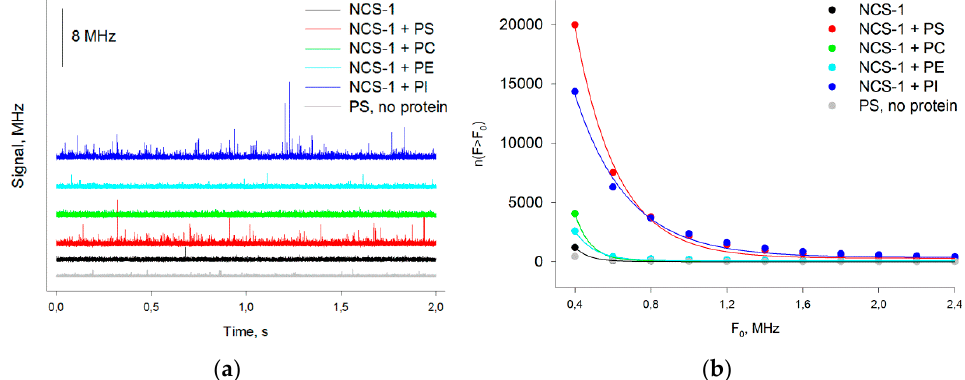
Figure A1. Binding of sulfo-cyanine-3-NCS-1 to liposomes monitored by fluorescence correlation spectroscopy (FCS). ( a ) Representative FCS curves for myristoylated Ca 2+ -bound NCS-1 in the absence (black) and in presence of liposomes made of PS (red), PC (green), PE (cyan), and PI (blue). ( b ) Total count of FCS peaks with amplitude higher than F 0 for all the recordings from Figure A1a.